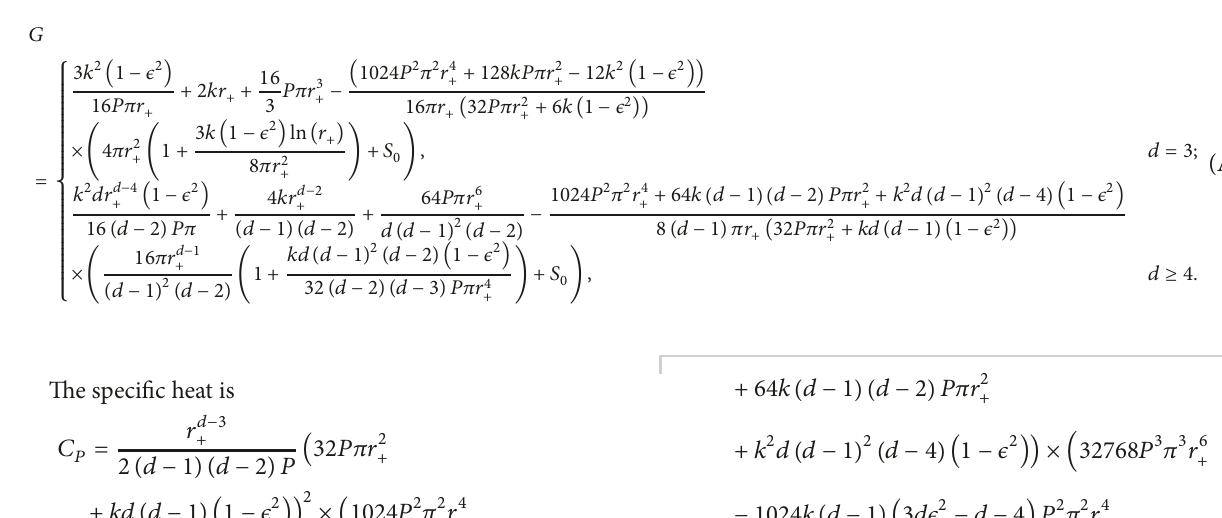
Figure 7: Curves of 𝐺 − 𝑃 with 𝑇 = 1/10 in four, five, and six dimensions for different “temperature” 𝜖 . In four and five dimensions, one can observe the classical “swallow tail” characterizing the small/large black holes phase transition when “temperature” 𝜖 > 𝜖 𝑐 , while no “swallow tail” exists for six